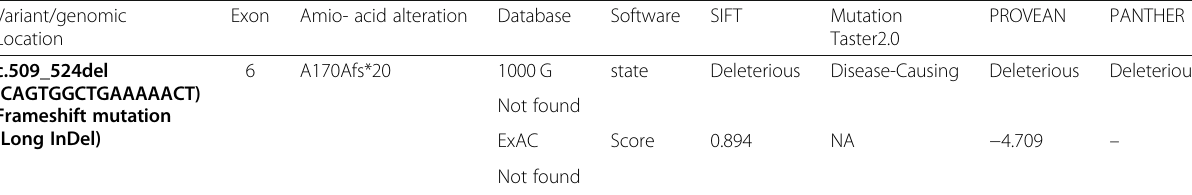
Table 1 In silico analysis of identified variants in the LRTOMT gene Variant/genomic Location